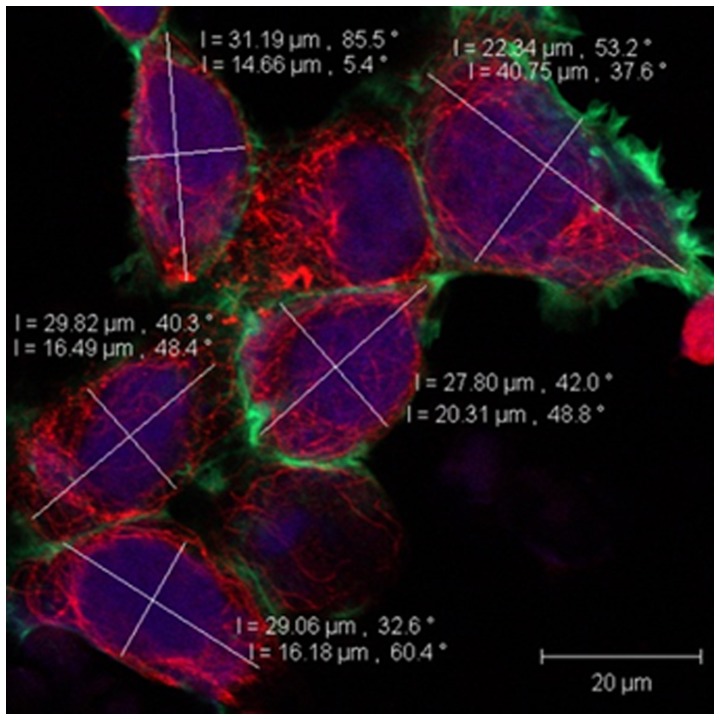
An example for the measurements of long and short diameters, corresponding to the major and minor axes of an ellipse, marked on the confocal images of the cells using designated image processing software.